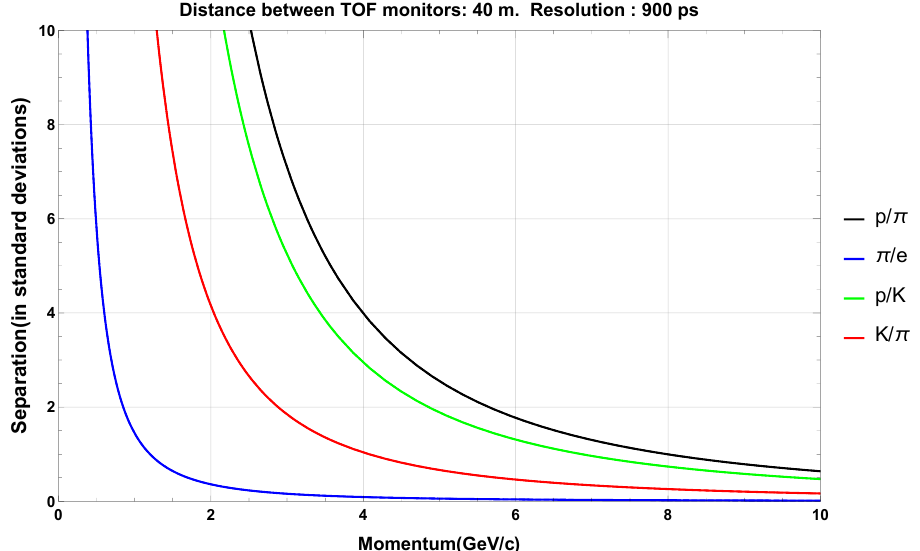
Figure 9. Separation of particles (expressed in standard deviations) for a time-of-flight resolution of 900 ps. Below 4 GeV/c TOFs achieve an excellent separation for protons, kaons and